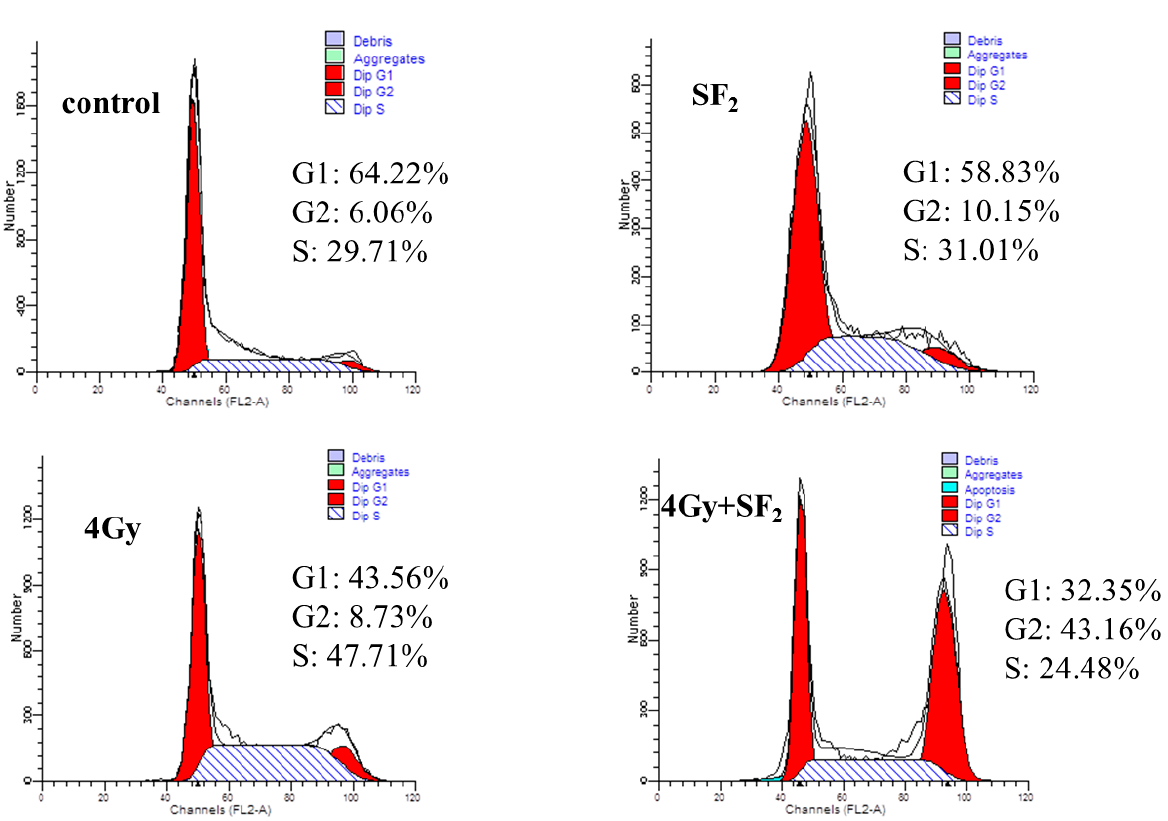
Figure 4. Cell cycle arrest induced by 60 Co γ -irradiation in A549 cells by the FACS